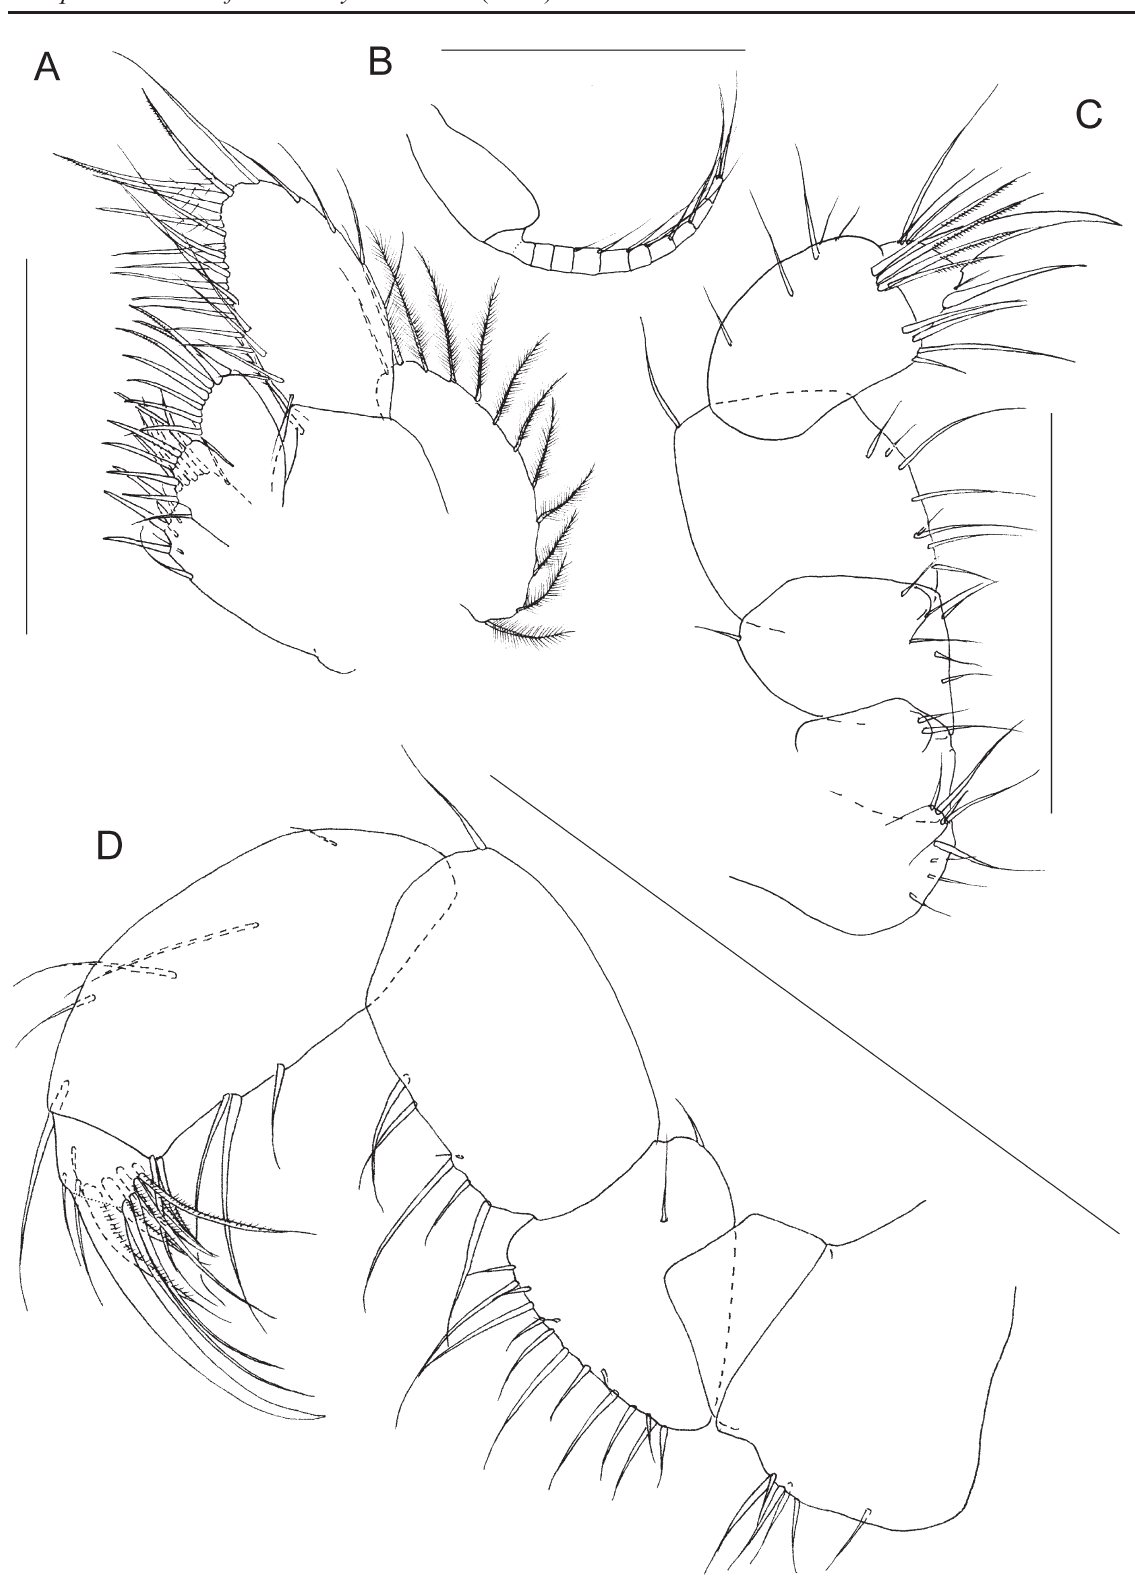
Fig. 9. Siriella brevicaudata Paulson 1875, ♂, length 4.5 mm, Arabian Gulf, Bahrain. A . Maxilla 2, anterior view. B . Exopod of maxilliped 1. C . Endopod of maxilliped 1, posterior view. D . Endopod of maxilliped 2, anterior view. Scale bars: A, C–D = 0.25 mm; B = 0.5